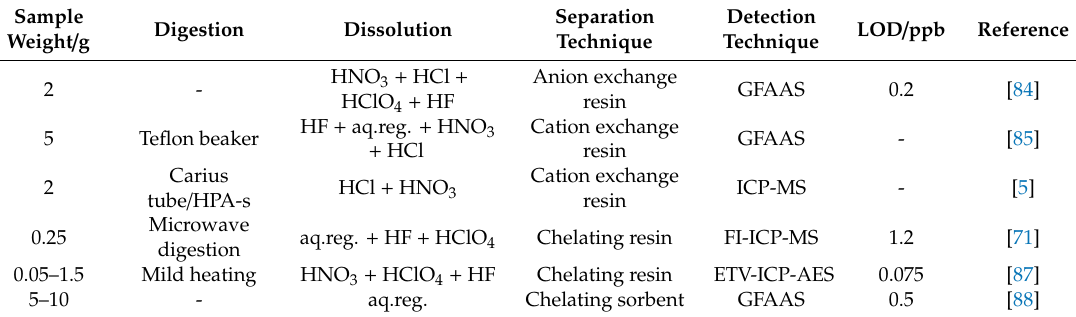
Table 4. Various methods for the preconcentration of Au by ion exchange